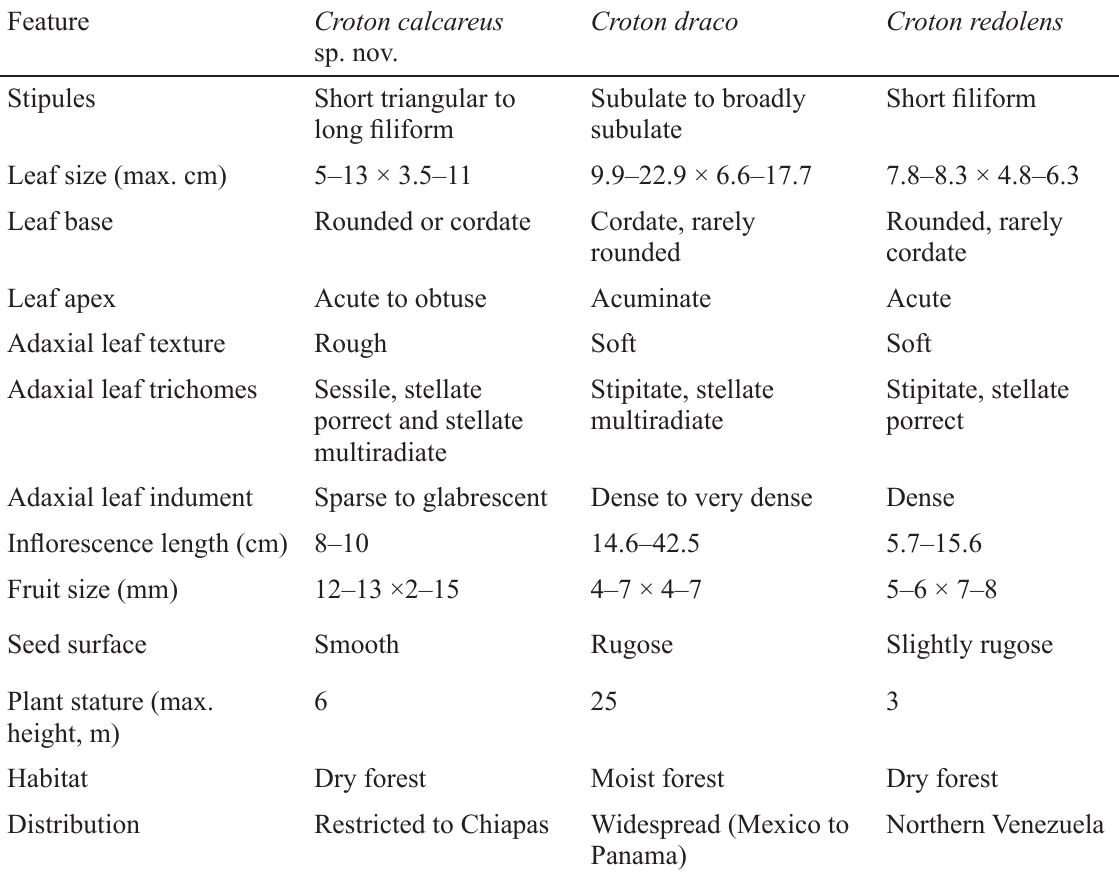
Table 2. Main differences between Croton calcareus Riina & Mateo-Ram. sp. nov., C. redolens Pittier and C. draco L. (the only other species in C . sect. Cyclostigma Griseb. occurring in